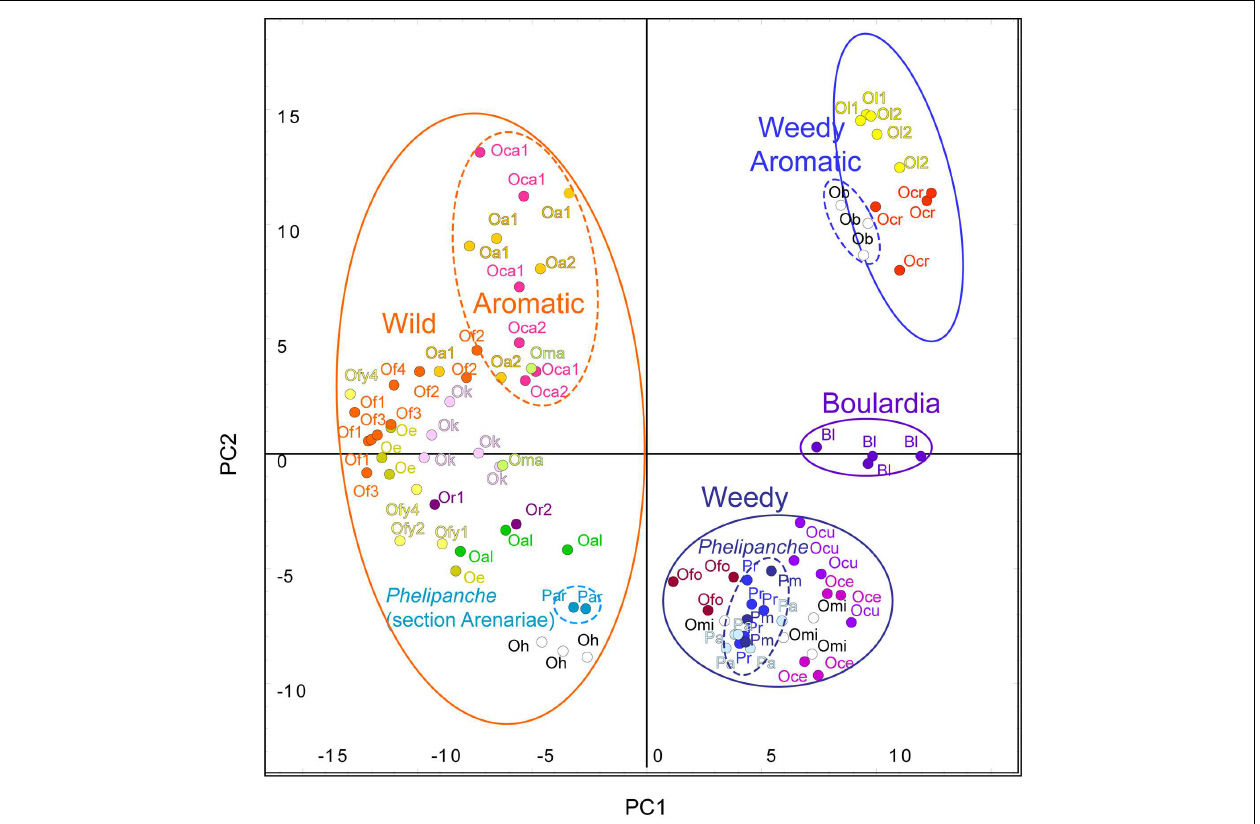
FIGURE 5 | Principal component analysis of the floral blends of the 21 European broomrapes studied (including Boulardia latisquama ). PCA was done with compounds showing a significant difference between the species ( P < 0.05 from ANOVA test) and it was performed by GeneMath XT on a data subset with broomrapes only. Letters and symbols represent single species. Group of wild broomrapes: Oa1, Oa2 , Orobanche alba (location 1, 2), Oal , O. alsatica ; Oca1, Oca2 , O. caryophylacea (location 1, 2); Oe , O. elatior ; Of1–Of4 , O. flava (location 1,2,3,4); Ofy1,2,4 , O. flava yellow morph (location 1,2,4); Oh , O. hederae (White color); Ok , O. kochii ; Oma , O. mayeri ; Or1, Or2 , O. reticulata (location 1,2); Par , Phelipanche arenaria . Group of weedy broomrapes: Ob , O. ballotae (White color); Oce , O. cernua ; Ocr , O. crenata ; Ocu , O. cumana ; Ofo , O. foetida ; Ol1, Ol2 , O. lutea (year 1,2); Omi , O. minor (White color); Pa , Ph. aegyptiaca ; Pm , Ph. mutelii ; Pr , Ph. ramosa . Other broomrapes: Bl , Boulardia